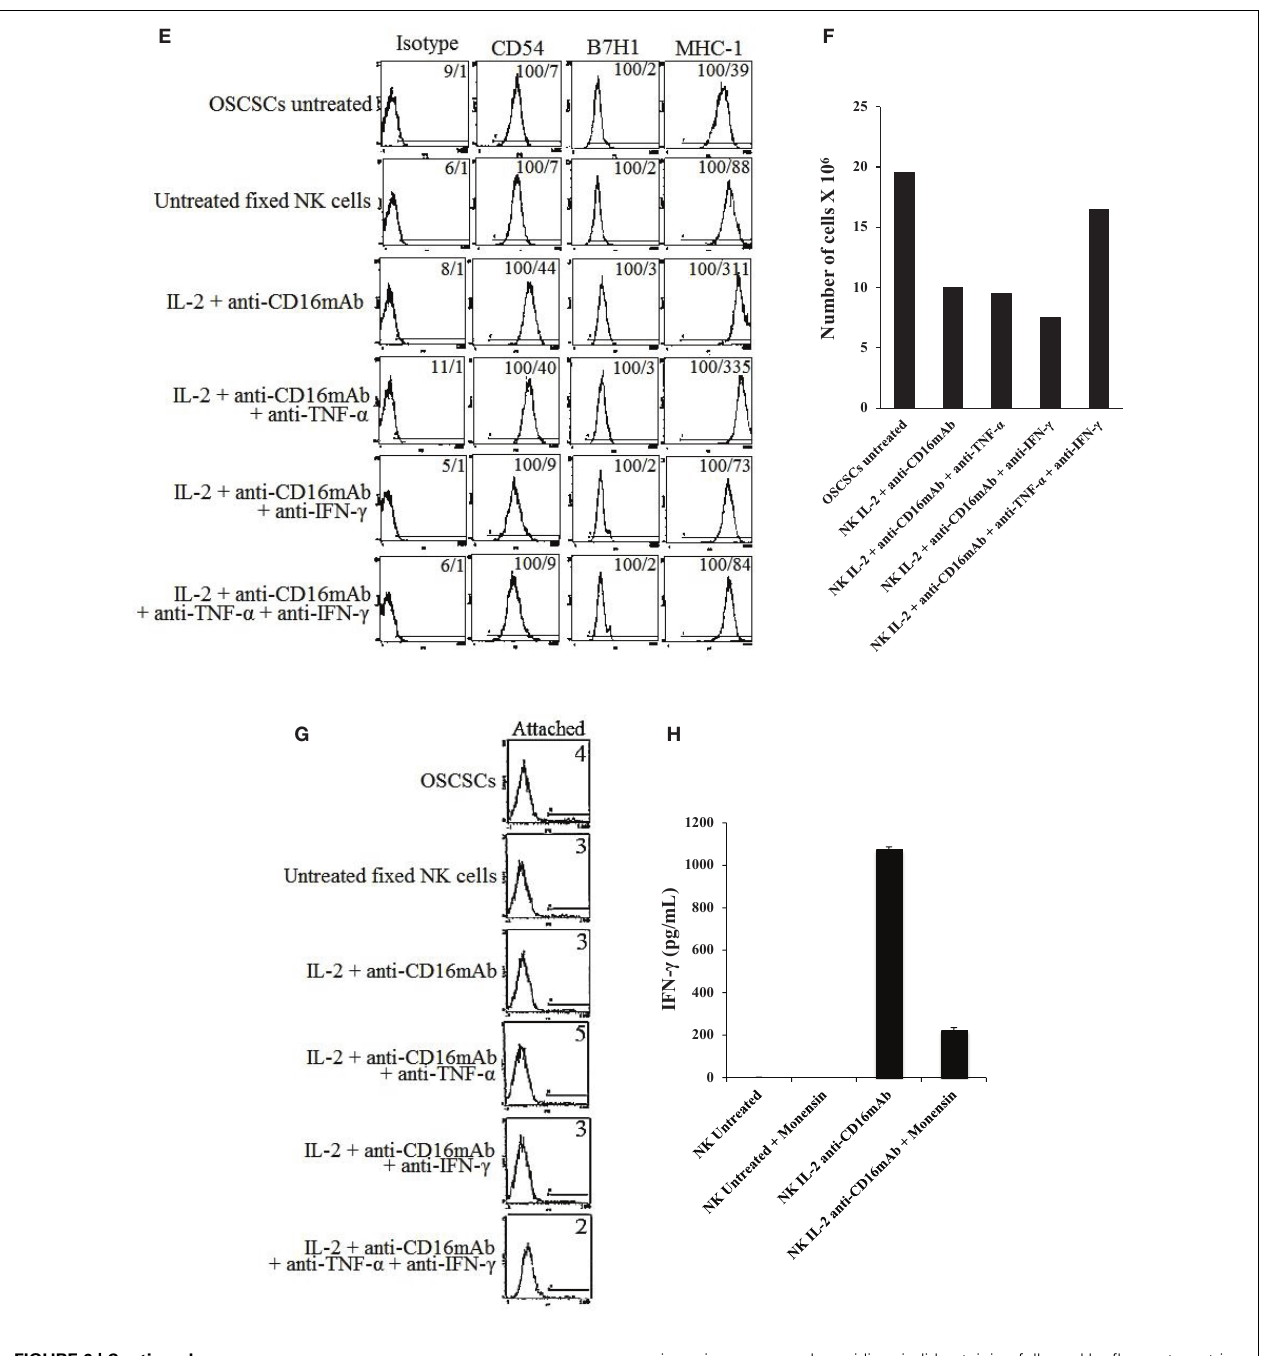
FIGURE 6 | Continued (D) The surface expression of CD54, CD44, B7H1, and MHC class I on untreated and fixed NK-treated OSCSCs as described above were assessed after PE-conjugated antibody staining followed by flow cytometric analysis. Isotype control antibodies were used as controls.The numbers on the right hand corner are the percentages and the mean channel fluorescence intensities for each histogram (E) . At the end of the incubation of OSCSCs with fixed NK cells, OSCSCs which were remained attached to the plate were collected, and the number of cells (F) and their viability (G) were assessed